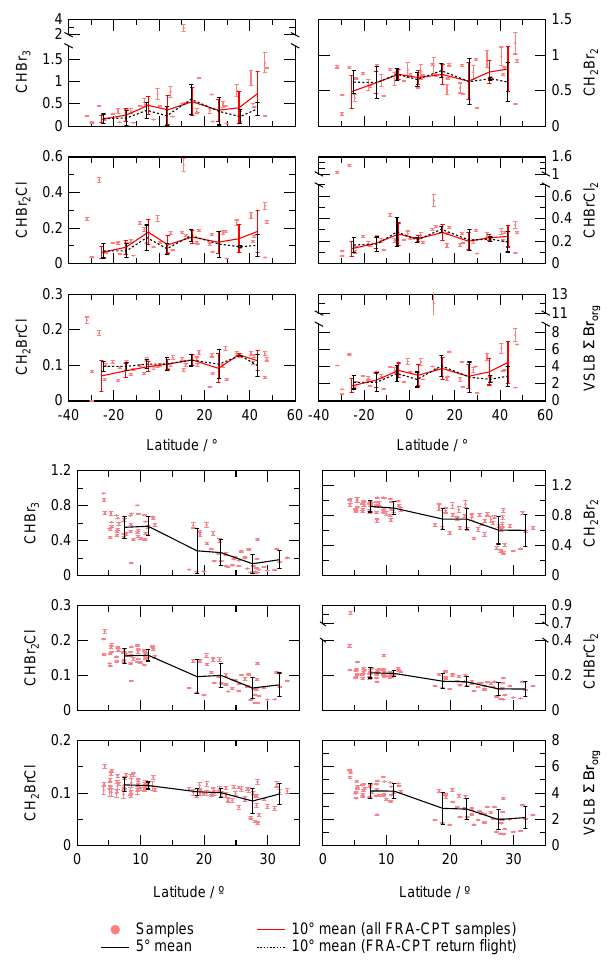
Fig. 7. Latitudinal distributions in South African (top) and South- east Asia (bottom) flights of VSLB and total VSLB-derived bromine (VSLB 6 Br org ) with 10 ◦ (South African flights) and 5 ◦ (Southeast Asia) latitudinal means of tropospheric samples above 10km altitude with 1 σ error bars representing variability. Latitudi- nal averages for South African flights are are shown for all samples and for samples collected on the return flight (see Sect. 3.2). All samples in both routes are tropospheric (following the definition in Sect. 3) with error bars representing analytical uncertainties. All VSLB values on the horizontal axes are given in